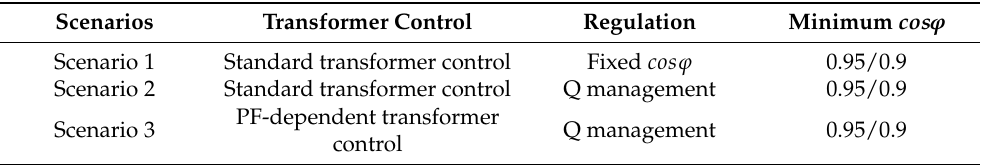
Table 3. Overview of scenarios for the assessment of theoretical and technical potential.